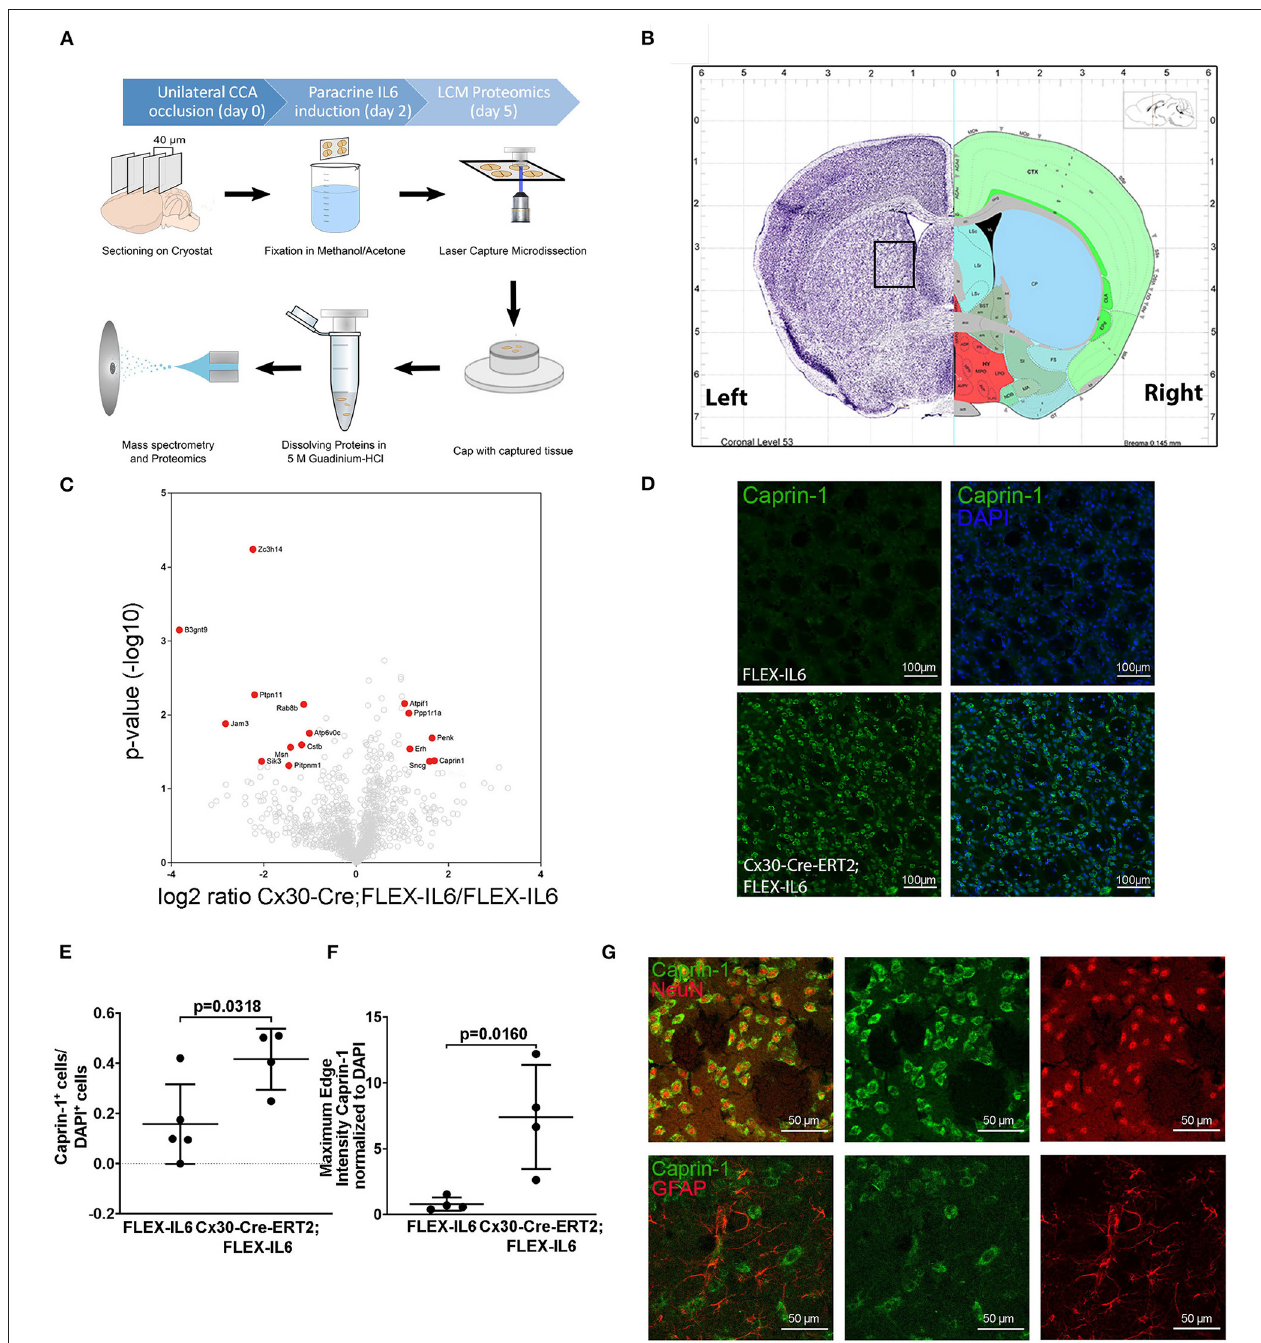
FIGURE 4 | Paracrine IL − 6 induces changes of the proteome in the striatum. (A) Schematic illustration of the laser capture microscopy (LCM) workflow. Five FLEX-IL6 and four Cx30-Cre-ERT2;FLEX-IL6 mice were used. Paracrine IL-6 secretion was induced 2 days after left-sided unilateral CCA occlusion. Brain tissue is sectioned into 40 µ m thick coronal slices and mounted on PEN membrane slides. After methanol/acetone fixation, the tissue is processed with the laser capture microscope. Striatal fiber bundles on the hypoperfused side were isolated. The addition of 5M guanidinium chloride dissolves the tissue and denatures the proteins. The sample was analyzed using mass spectrometry for proteome analysis. (B) Illustration (Allen mouse Brain Atlas) of the anatomical region used for LCM. (C) The volcano plot shows log ratio and p -value distribution of all quantified proteins. Proteins with significantly ( p < 0.05, fold change > / < 2) altered expression are labeled in red. We identified 16 differentially regulated proteins listed in Table 1 . (D) Comparison of caprin-1 staining in FLEX-IL6 and Cx30-Cre-ERT2;FLEX-IL6 mice confirms elevated caprin-1 expression in mice with increased paracrine IL-6. (E,F) Automated quantification of nuclei and co-detection of Caprin-1 intensity resulted in a significant increase of the edge nuclei intensity in the caprin − 1 channel normalized to DAPI intensity. (G) Co-staining of caprin-1 and NeuN and GFAP showed that caprin-1 is localized exclusively in neurons and not detected in astrocytes. Graphs show scatter dot plots of data from individual mice ± standard deviations. (E,F) Two-tailed unpaired Student’s t